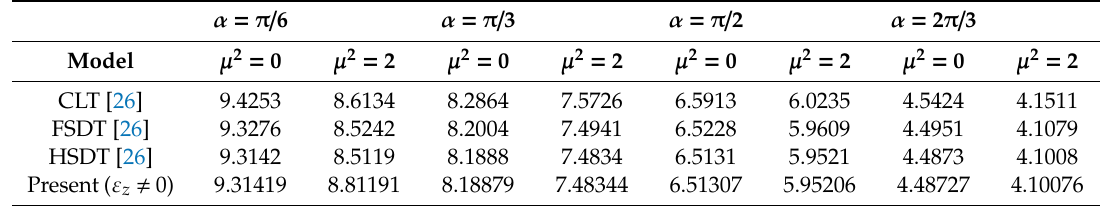
Table 1. A comparison between the natural frequency of isotropic curved nanobeam ( L / h = 10). α = π / 6 α = π / 3 α = π / 2 α = 2 π /